Question: Give a one-sentence summary of this figure.
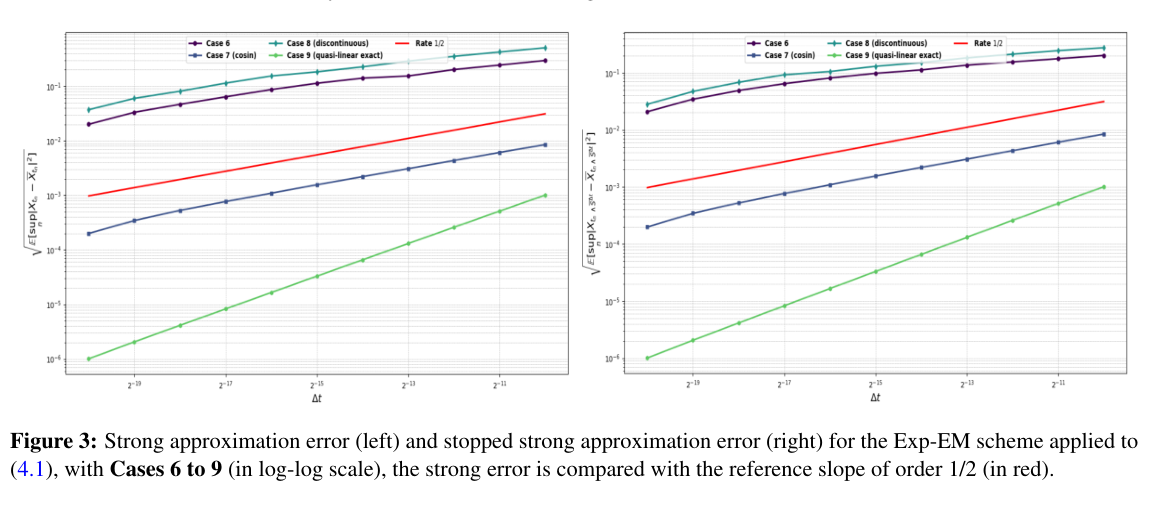
Answer: Strong approximation error (left) and stopped strong approximation error (right) for the Exp-EM scheme applied to (4.1), with Cases 6 to 9 (in log-log scale), the strong error is compared with the reference slope of order 1/2 (in red).